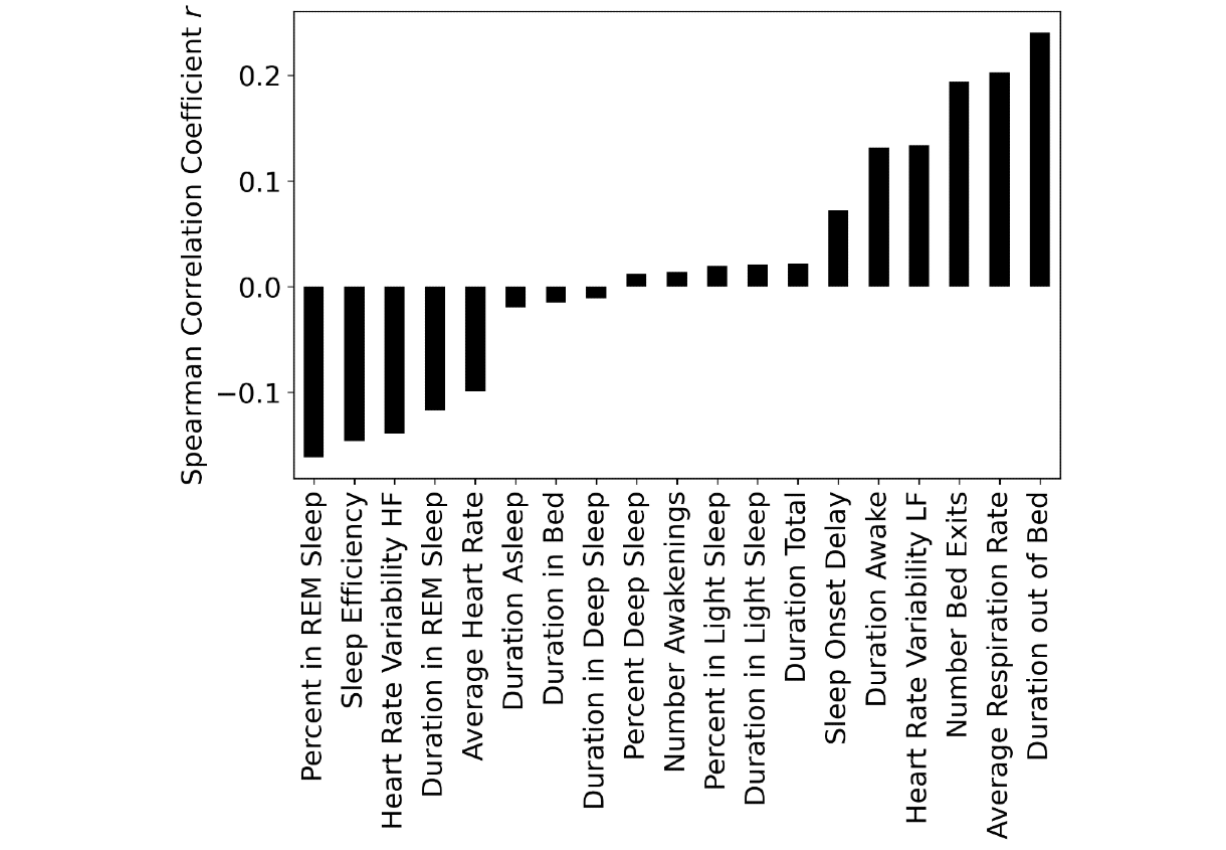
Figure 3. Relationship between number of toss-and-turns and the remaining sleep